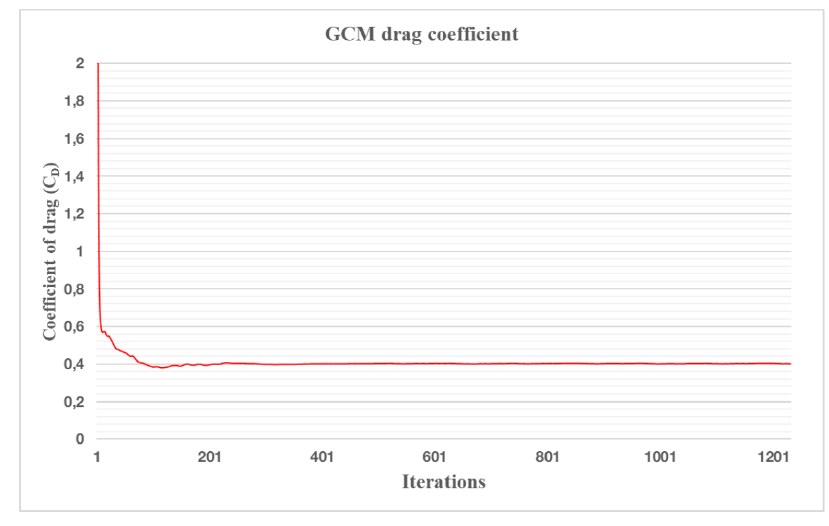
Fig. 7. Drag coefficient graph for the